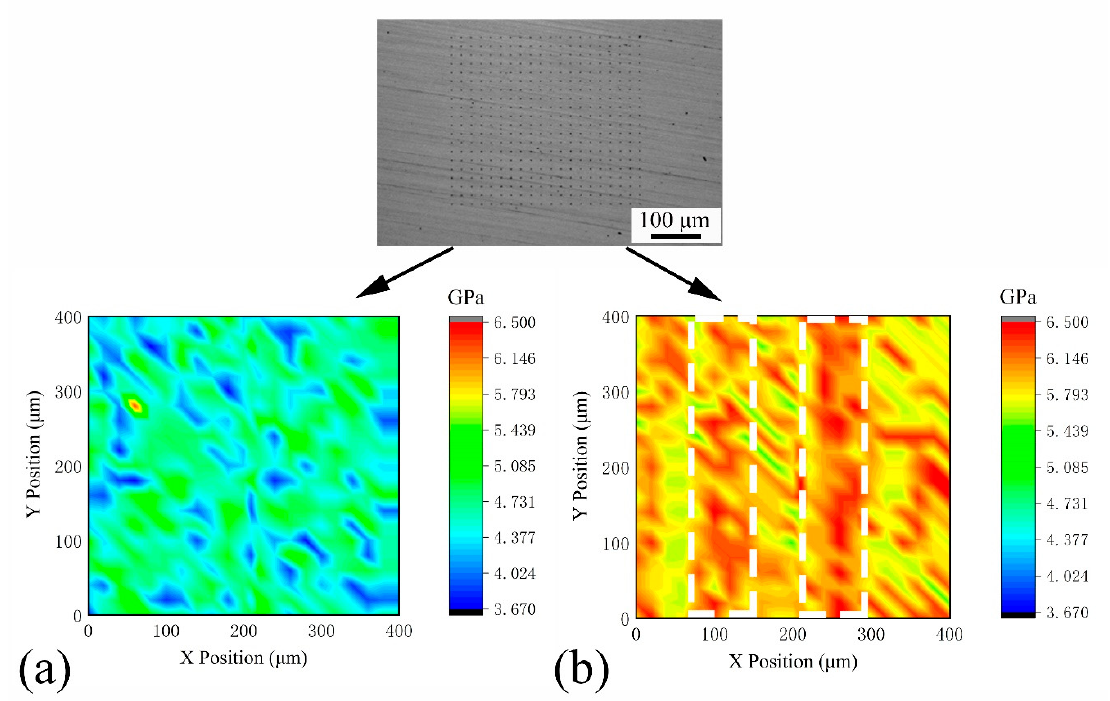
Figure 11. Distribution of the hardness values of the bainitic steel; ( a ) untreated specimen and ( b ) LSR specimen with d = 100 μ m.